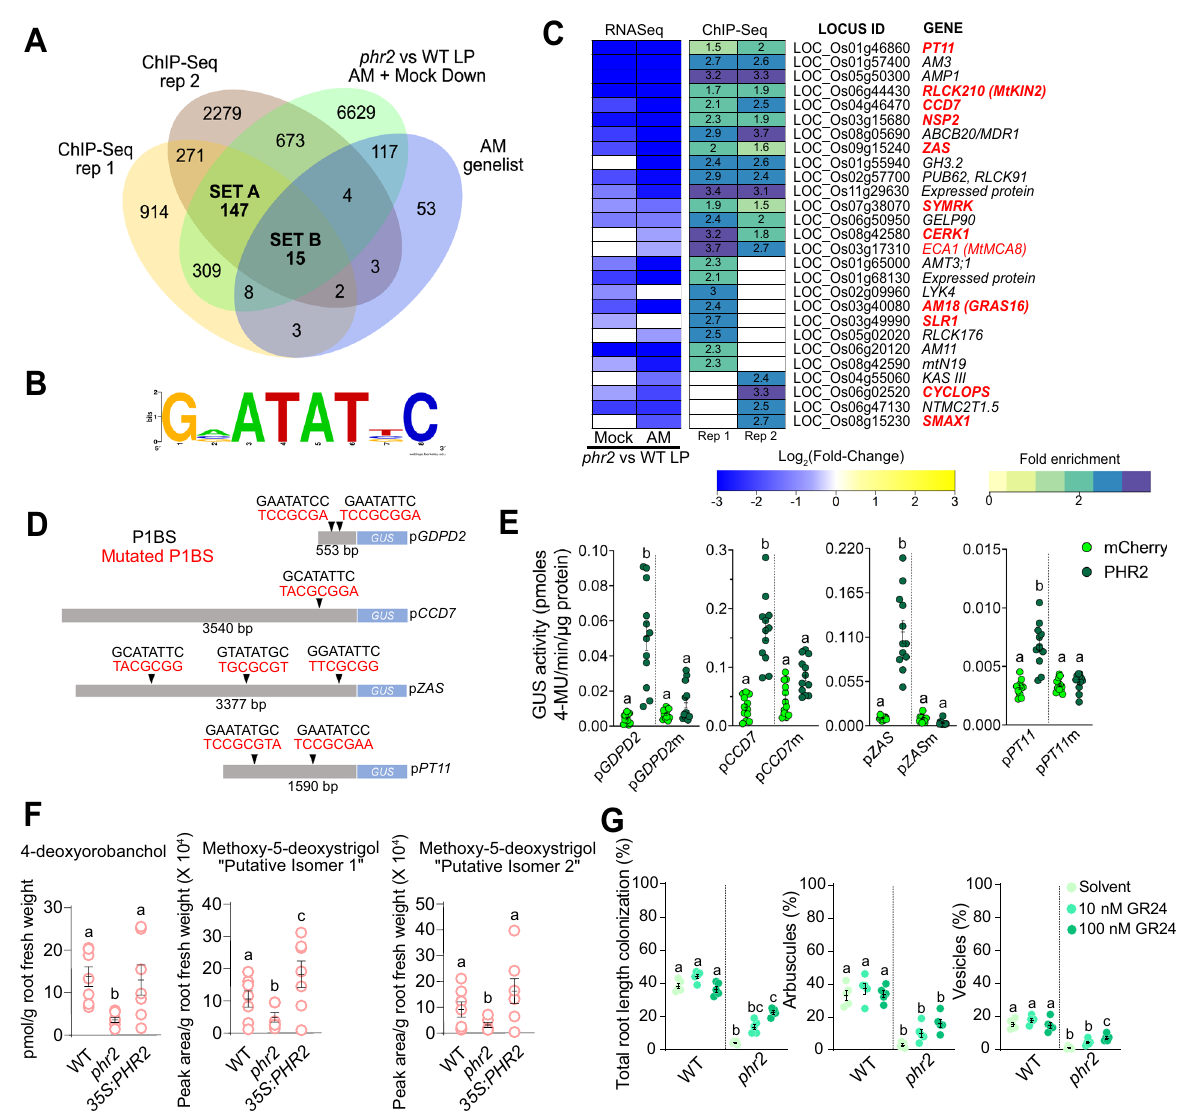
Fig. 3 PHR2 targets important AM symbiosis genes. A Overlap of PHR2 ChIP-Seq targets with RNASeq DEGs displaying reduced expression in Mock and AM roots of phr2 vs WT roots grown at LP and with AM genelist (Supplementary Data 4). B Consensus PHR2-binding motif for Set A + Set B genes based on ‘ RSAT Plants ’ oligo-analysis. C Fold change of RNAseq-based transcript accumulation in Mock and AM roots of phr2 vs WT grown at LP (left) and ChIP- Seq fold enrichment for PHR2 binding (right) for the 27 genes hit in at least one ChIP-Seq replicate and overlapping with phr2 vs WT down and AM genelist. Genes with assigned functional roles in AM, based on mutant phenotypes are displayed in red (bold for mutants, regular font for RNAi lines). D Illustration of promoters used in transactivation assays with positions of PHR1 binding site (P1BS) elements (black) and mutated P1BS elements (red). E PHR2 transactivates the promoters of GDPD2 , CCD7 , ZAS, and PT11 (553, 3540, 3377, and 1590 bp upstream of ATG, respectively) in a P1BS element- dependent manner in Nicotiana benthamiana leaves. promoter : GUS fusions were co-transformed with 35S : PHR2 or 35S : mCherry (negative control). ‘ m ’ indicates that all P1BS elements in the promoter were mutated. Individual dots show GUS activity in protein extracts from leaf disks from four independent plants. GUS: β -glucuronidase. F Quantity of 4-deoxyorobanchol and two isomers of methoxy-5-deoxystrigol in the root exudates of WT, phr2 , and 35S:PHR2 grown at LP. G Percent root length colonization total (left), arbuscules (middle), and vesicles (right) of the indicated genotypes inoculated with R. irregularis for 6 weeks at low phosphate (25 µ M P i ) and treated with 0.02% acetone solvent or the synthetic SL analog rac -GR24. Statistics: Individual data points and mean ± SE are shown. E N = 11 – 12 biological replicates representing independent Agrobacterium in fi ltrations, one per leaf into 3 leaves of 4 individual plants; Kruskal – Wallis test with Dunn ’ s posthoc comparison. F N = 6 – 7 independent plants; Brown – Forsythe and Welch ’ s One-Way ANOVA test with Games – Howell ’ s multiple comparisons test. G N = 5 independent plants; Brown – Forsythe and Welch ’ s One-Way ANOVA test with Games – Howell ’ s multiple comparisons test.